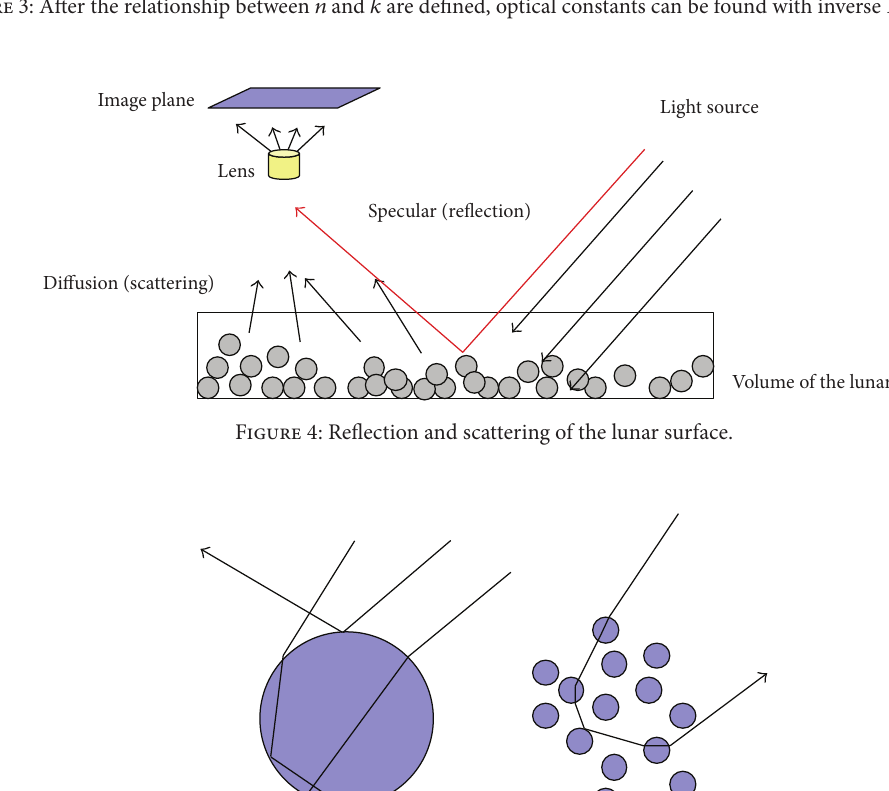
Figure 3: After the relationship between 𝑛 and 𝑘 are defined, optical constants can be found with inverse Hapke’s model.